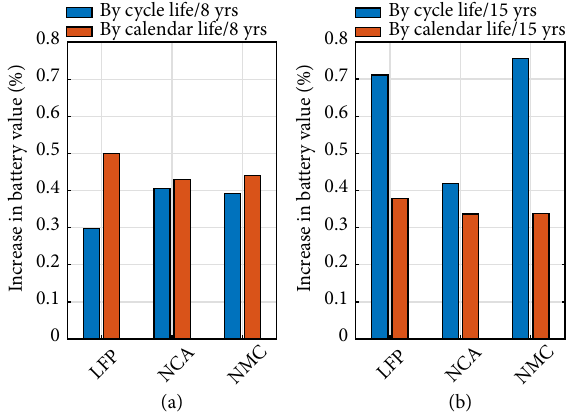
Fig. 6 Influence of 1% increase in cycle life and calendar life of the battery over its rated value in % across the locations in NYISO for (a) 8 years calendar life and (b) 15 years calendar